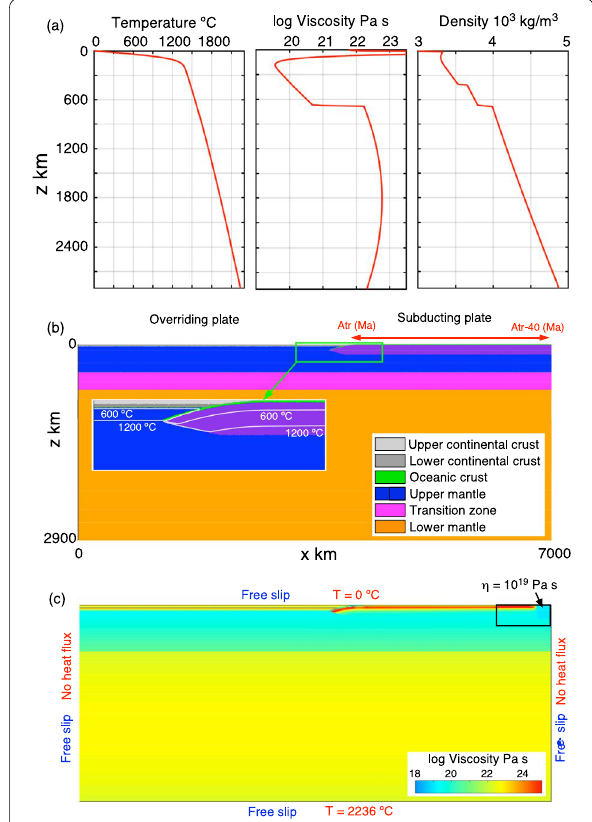
Fig. 1 a Distribution of temperature, effective viscosity and density in initial state. b Model geometry and material domains. c Boundary conditions for flow and temperature are shown in blue and red, respectively. Background color indicates initial distribution of effective viscosity. Material and temperature distribution of upper right corner (black rectangle) are reset every simulation step to keep the structure of the oceanic plate